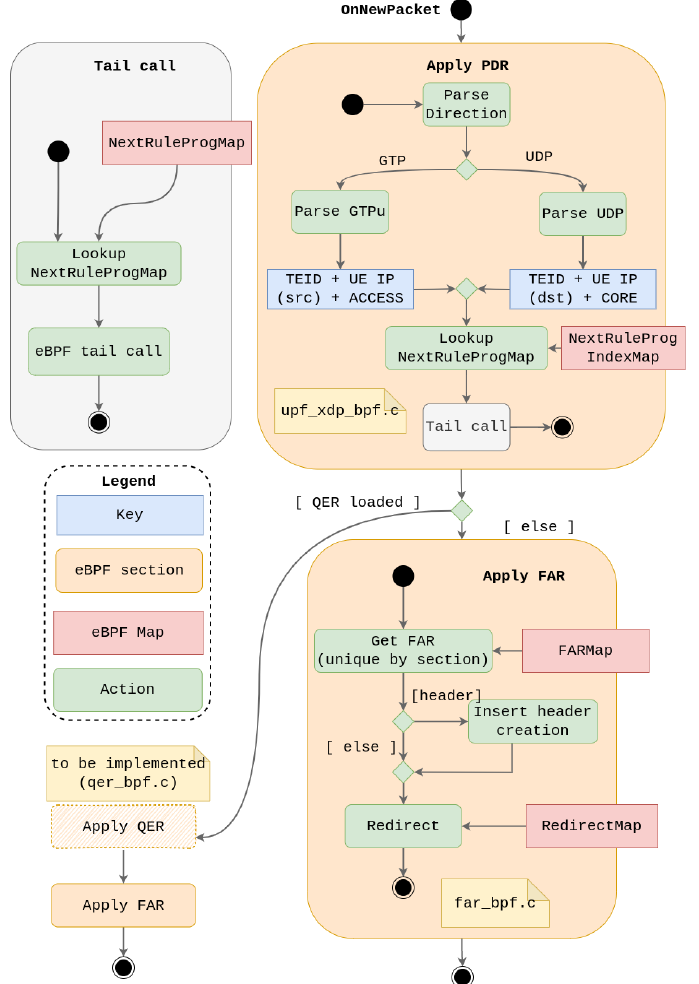
Figure 13. On new packet received activity diagram in Datapath Layer (version 2) .